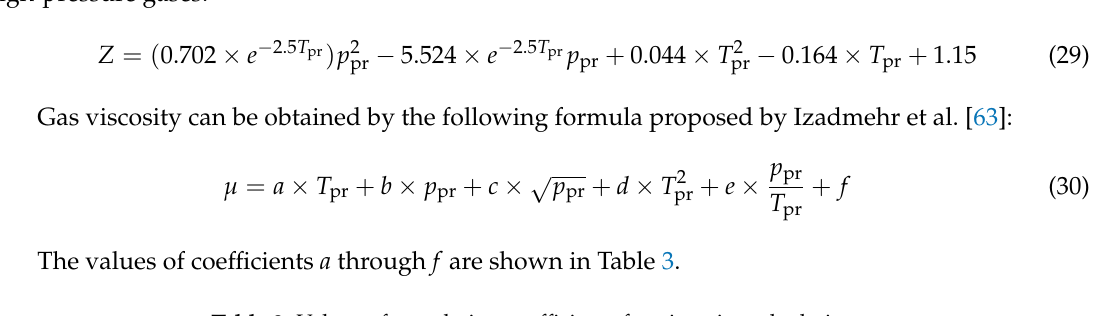
Table 3. Values of correlation coefficients for viscosity